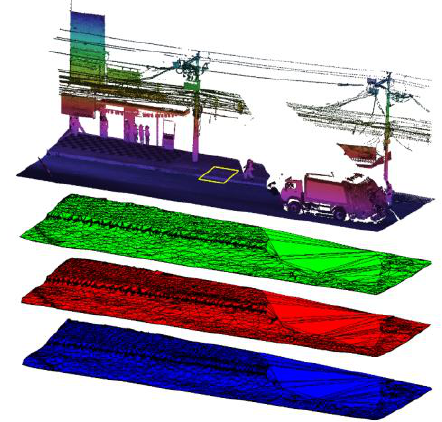
Figure 13. Height vegetation results